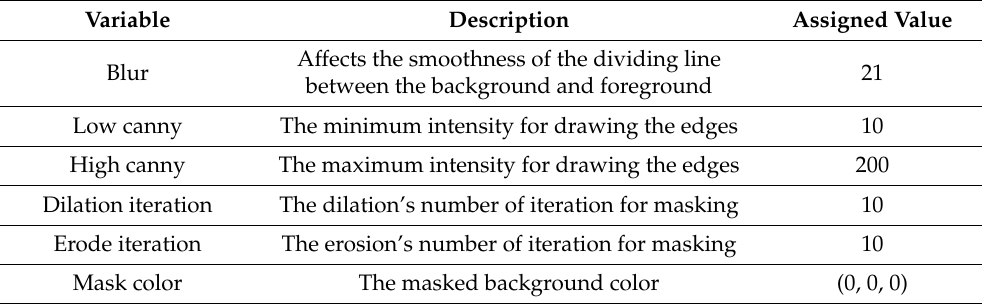
Table 1. The background removal’s set of variables and their descriptions and assigned values. Variable Description